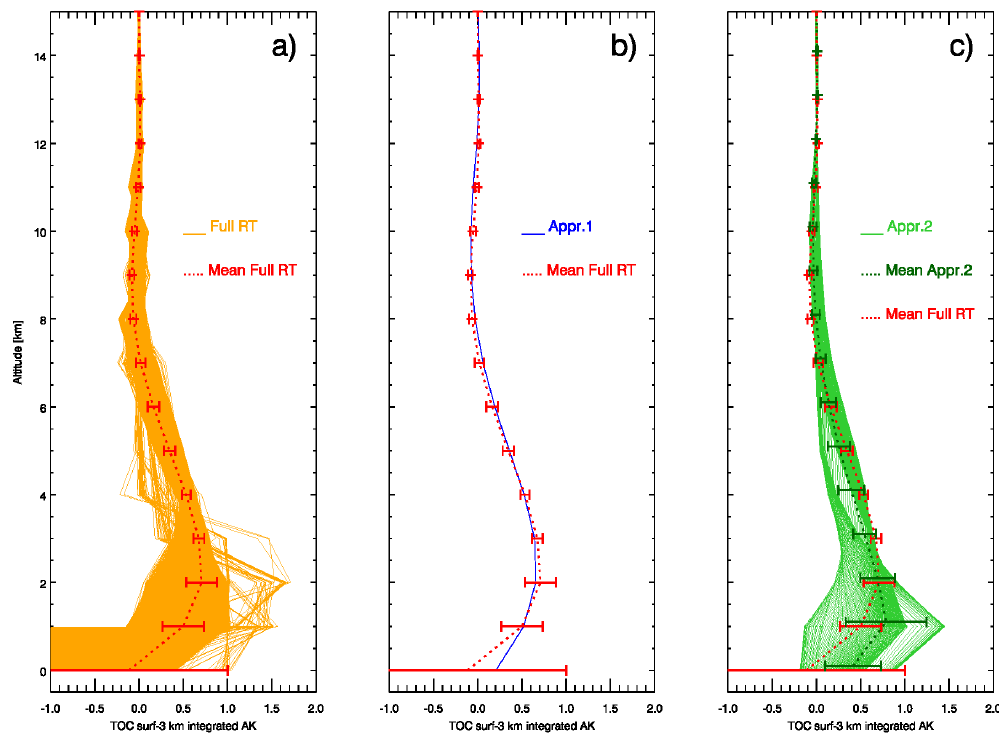
Fig. 2. Same as Fig. 1 but for the the ozone partial column from surface to